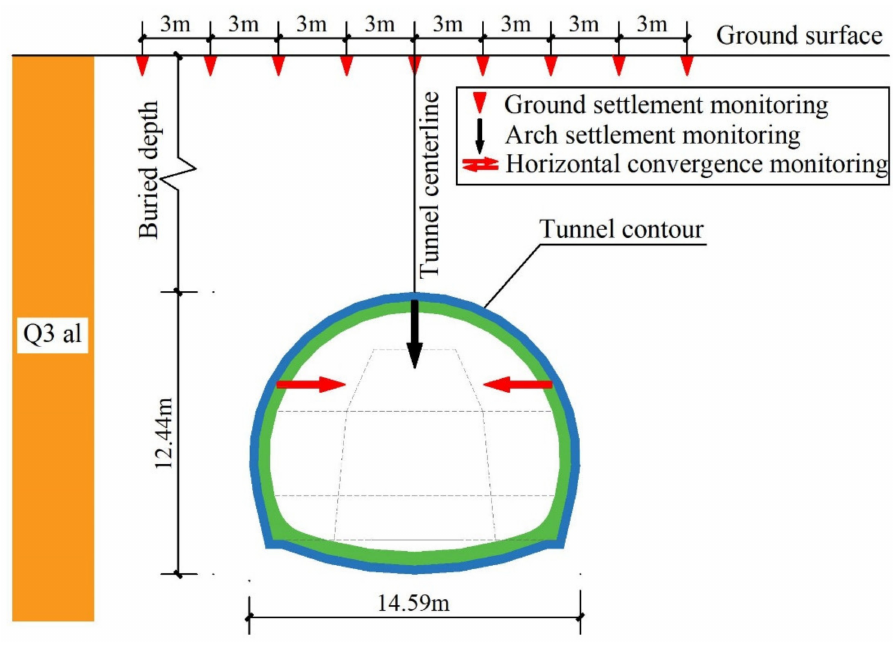
Figure 8. Layout of the monitoring points of monitoring sections.